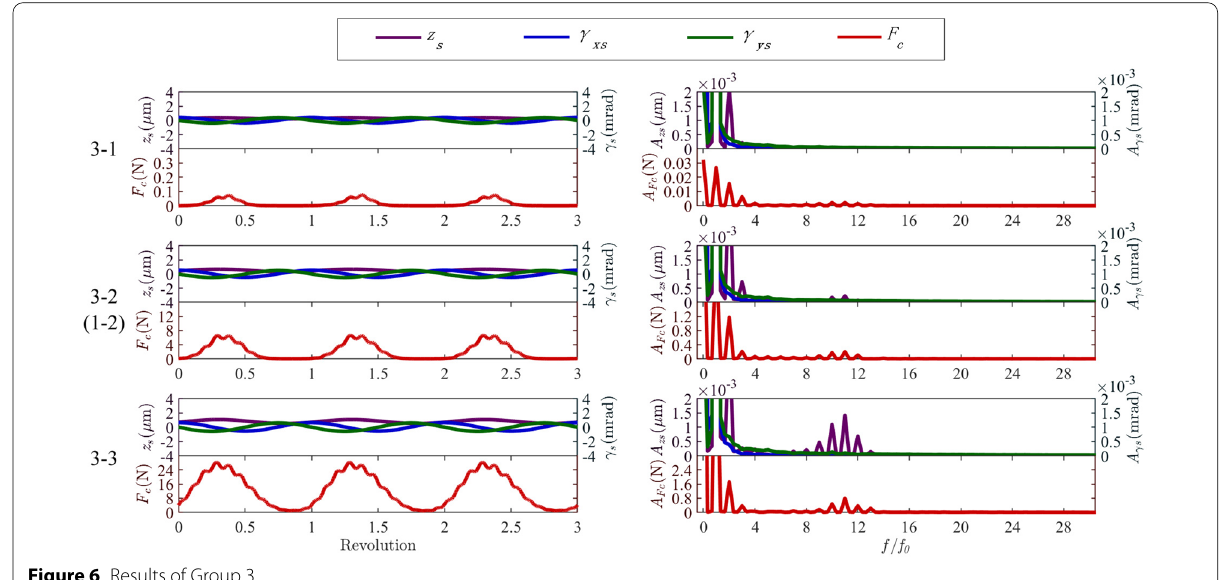
Figure 6 Results of Group 3